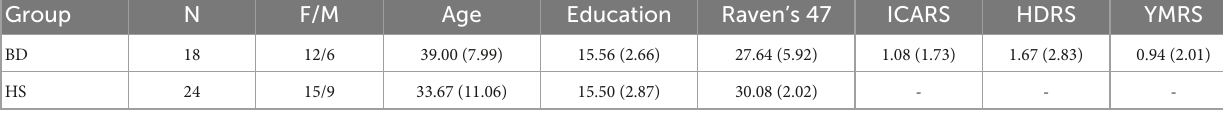
TABLE 1 Demographic characteristics of BD patients and controls.